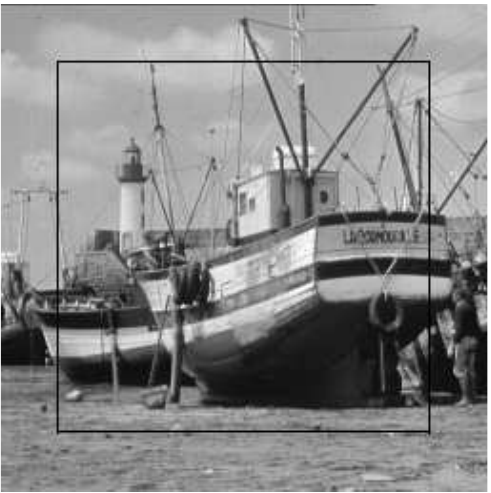
Figure 1. Field of view. We see what is inside the square